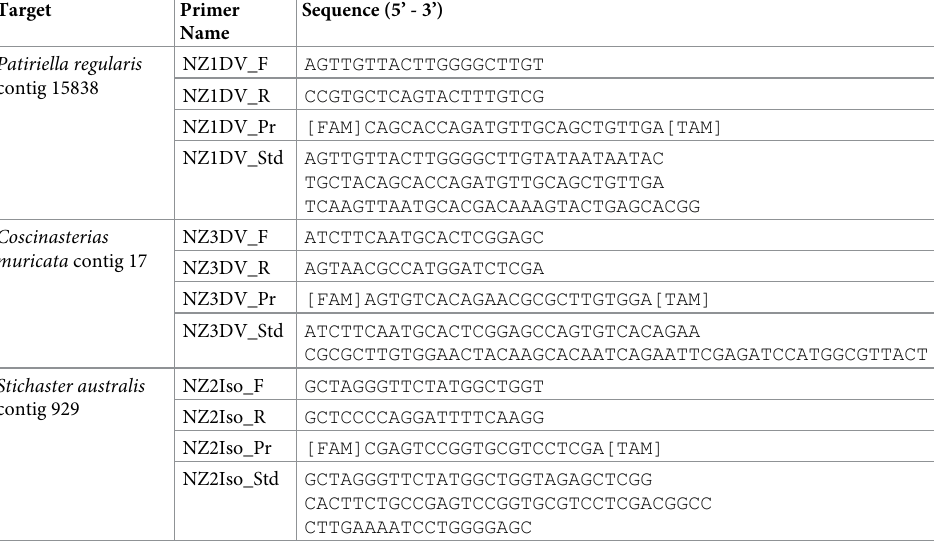
Table 3. Primers and probes used in this study to examine the prevalence and load of densovirus and mesomyce- tozoan-like contiguous